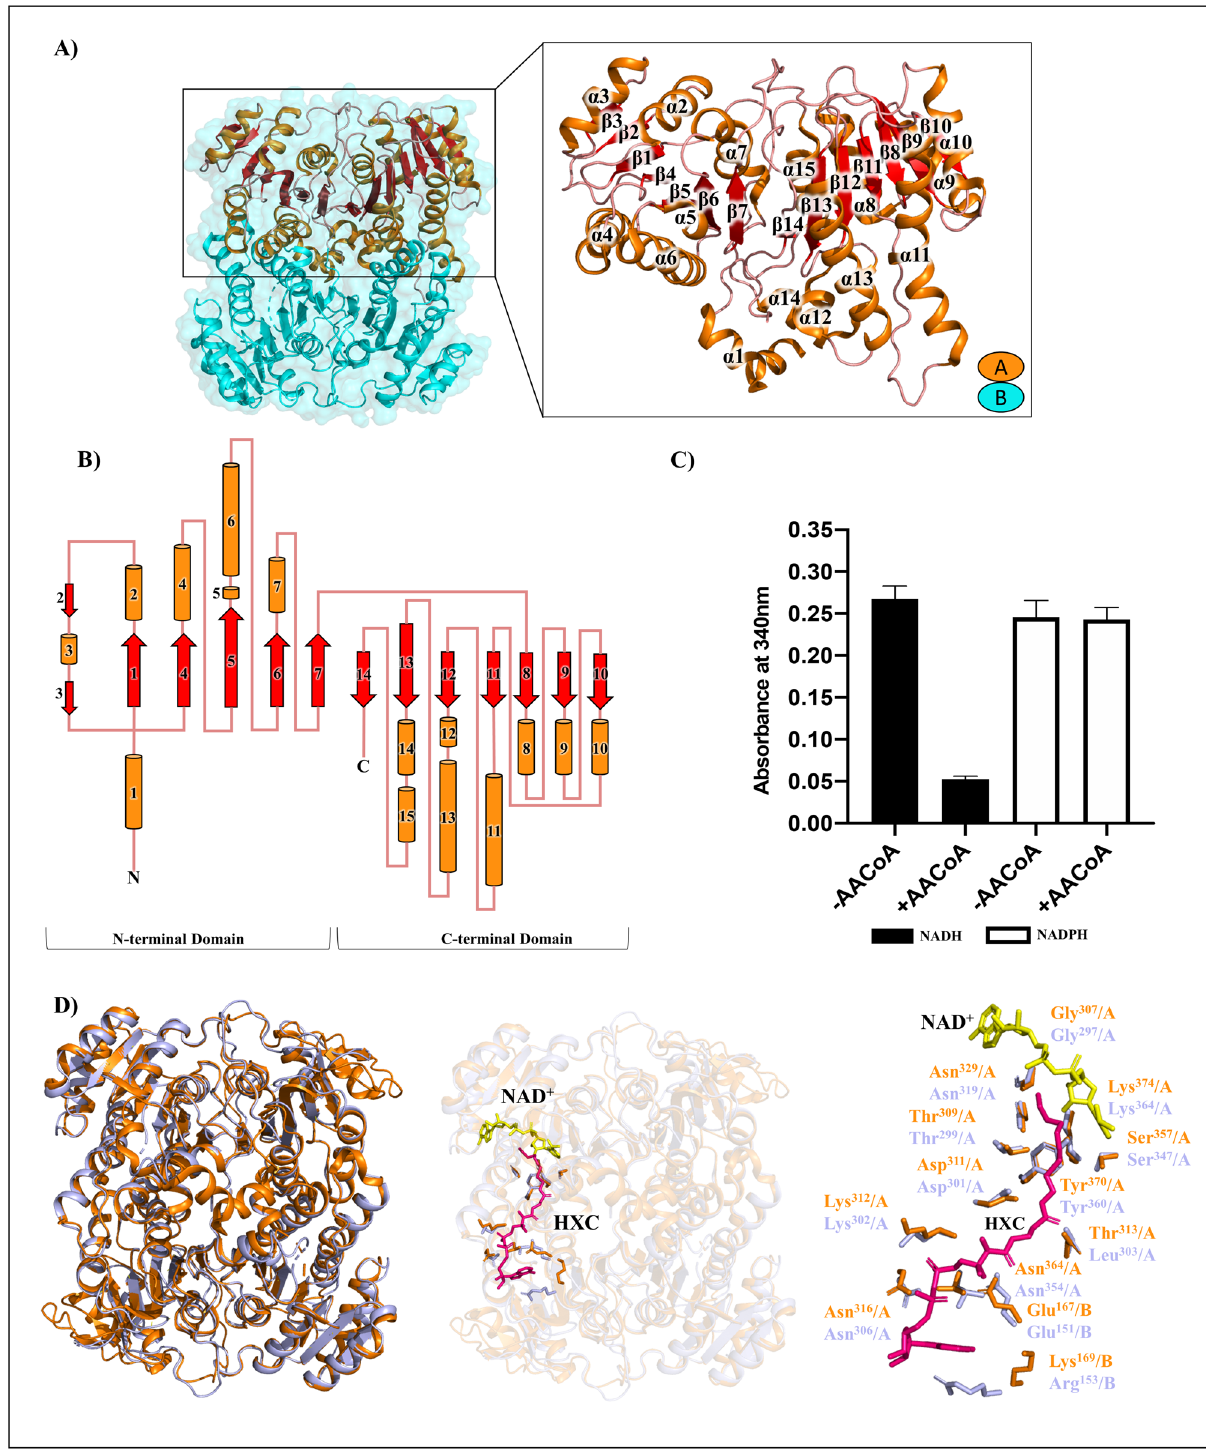
Figure 4. Structure of A. baumannii HMwFabG (ABO12488.2) ( A ) The dimeric quaternary assembly and protomer displaying the flavodoxin-like N-terminal fold and Rossmann C-terminal fold. Models were deposited in the PDB under the code 6UUV and 6UUT. ( B ) Topology diagram of protomer assembly with loops (salmon), α-helices (orange), and β-sheets (red). ( C ) Enzyme activity of HMwFabG with acetoacetyl-CoA. ( D ) Superimposition of A. baumannii HMwFabG (orange) and M. tuberculosis FabG4 (purple, PDB: 3V1U) (left panel), with hexanoyl-CoA (HXC, magenta) and NAD + (yellow) (middle panel), and superimposed active site showing conserved sidechains, coenzyme, and substrate (right panel). All figure images were generated/drawn by the